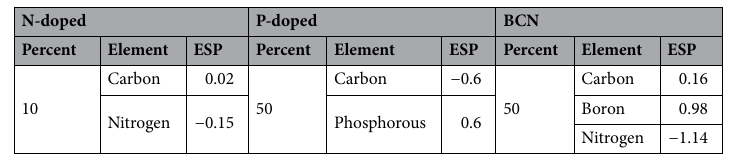
Table 1. The effect of doping on the electrostatic potential (ESP) distribution of fullerenes.